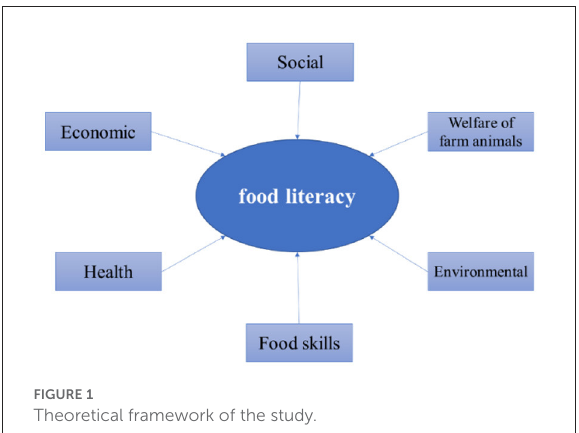
FIGURE1 Theoretical framework of the